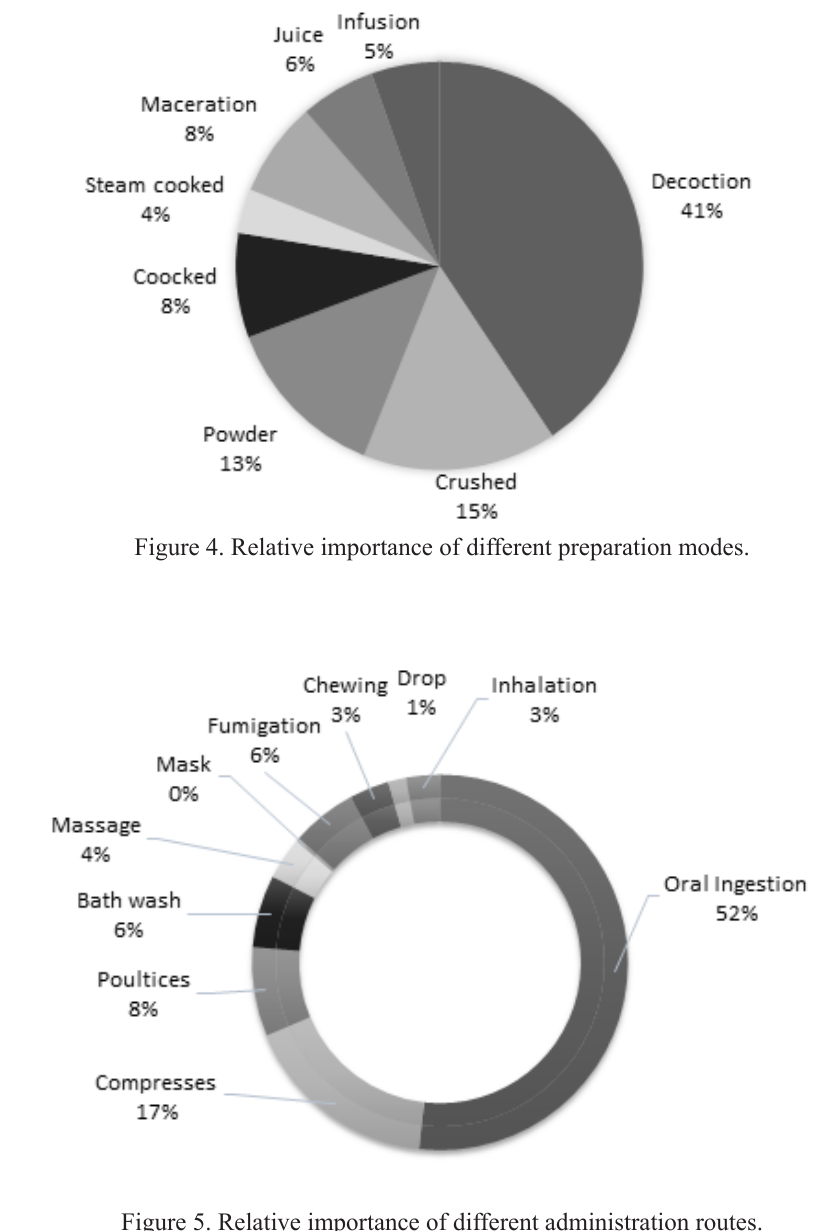
Figure 5. Relative importance of different administration